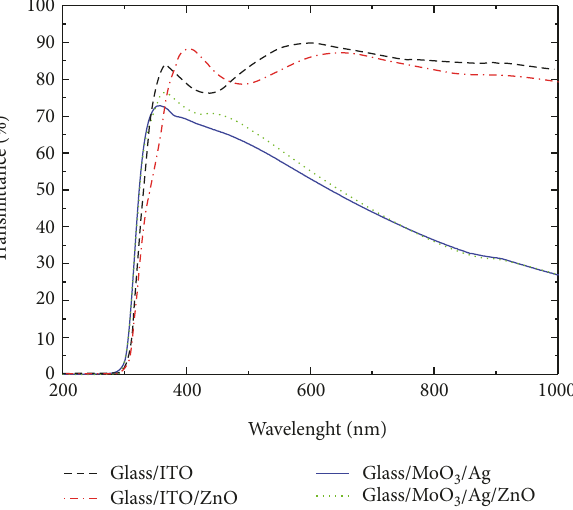
Figure 3: Optical transmittance of glass/ITO, glass/MoO glass/ITO/ZnO, and glass/MoO